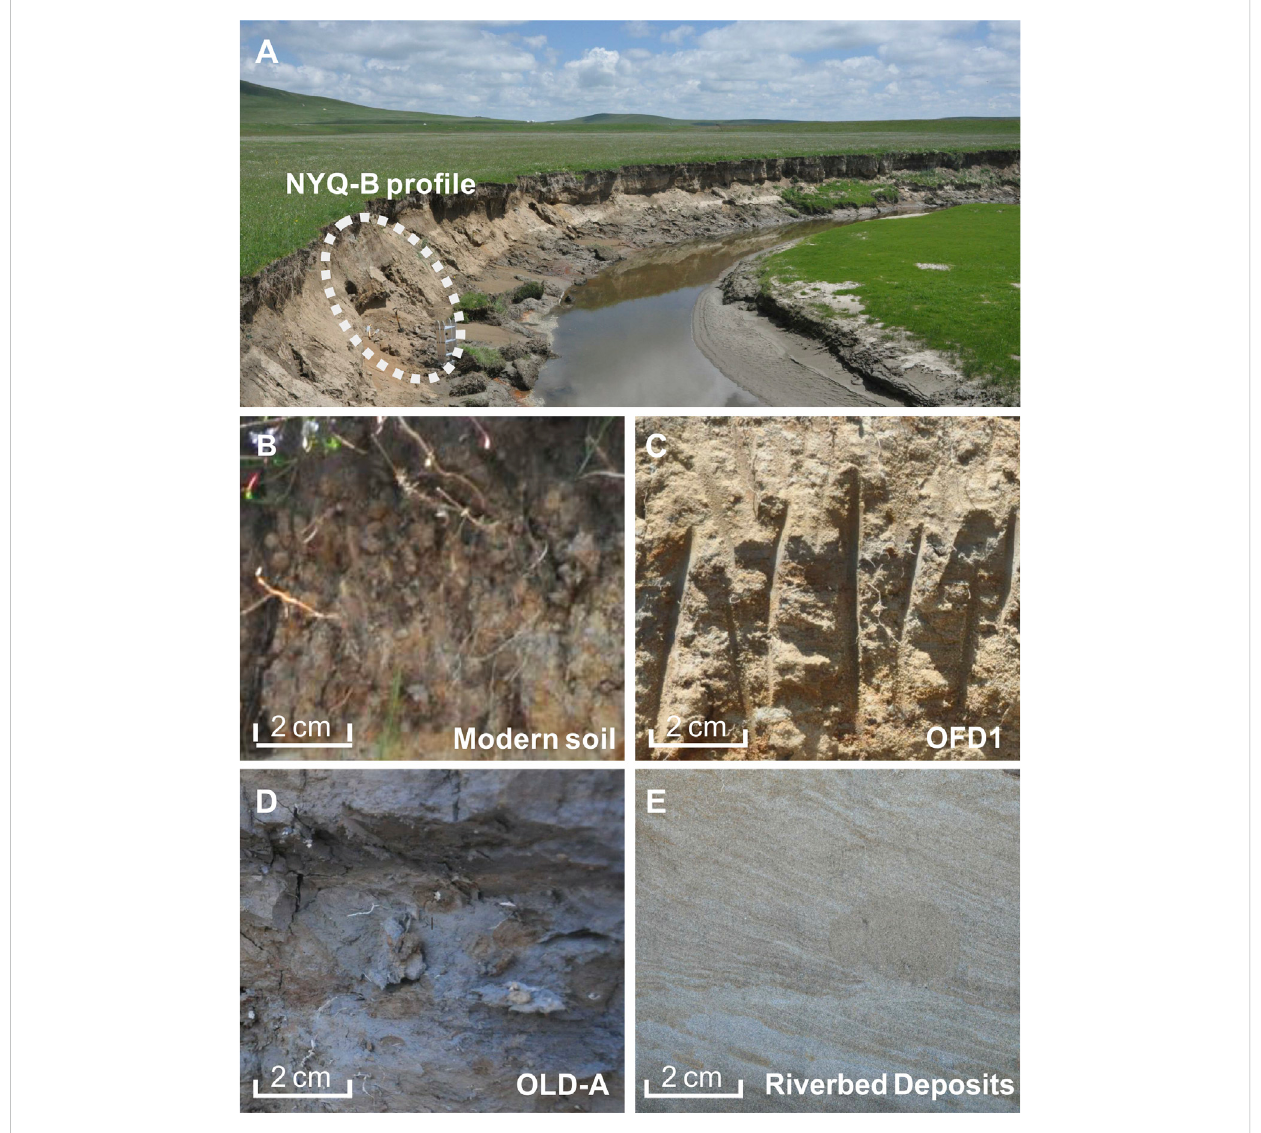
FIGURE 2 (A) Photo showing the paleo-oxbow lake fi ll at NYQ-B site within the Zoige Basin on the NE Tibetan Plateau. (B – E) Close-up shots